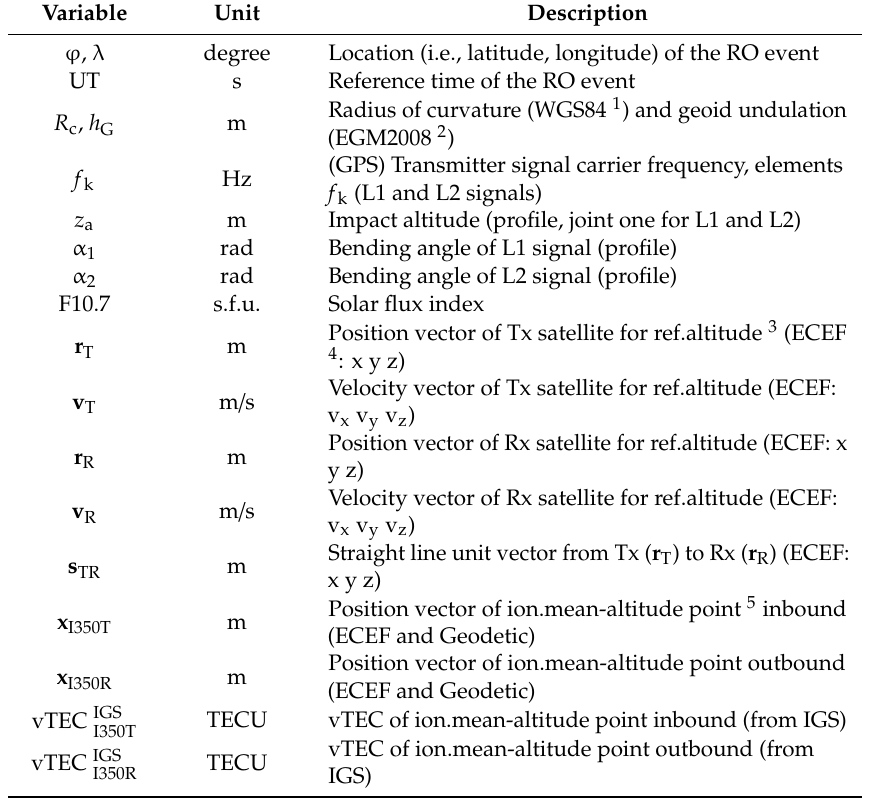
Table 1. Basic inputs for the bi-local correction, from preparatory computations in the